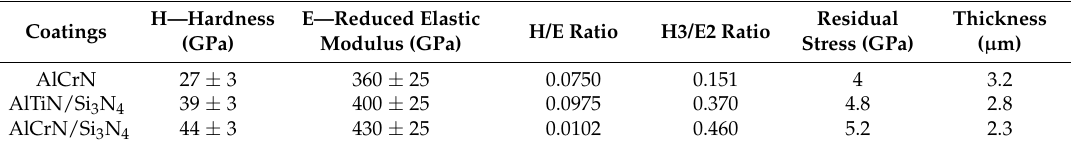
Table 2. Mechanical properties, residual stress, and thickness of the coatings.